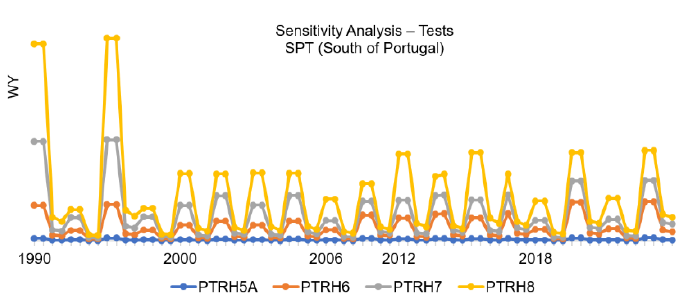
Figure 11. Sensitivity analysis tests by river basin district (RBD) of the South of Portugal.